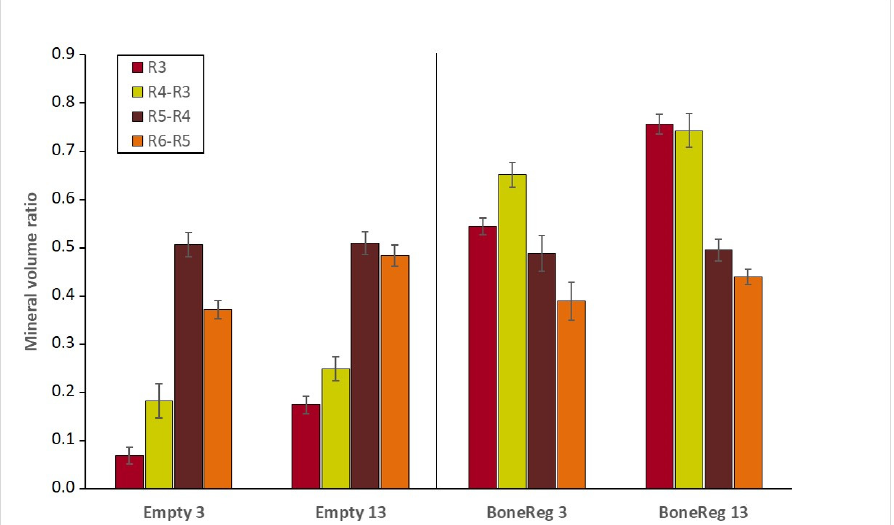
Figure 6. Mineral volume ratio in a virtual cylinder (R3) and tubes R4-R3, R5-R4 and R6-R5 in BoneReg-Inject™ samples after 3 months (BoneReg 3) and 13 months (BoneReg 13) and in the empty control (Empty 3 and Empty 13). Mean and SEM ( n = 15 for each treatment). Mineral content within the implanted scaffold at 13 months postoperatively was significantly higher than at 3 months postoperatively (R3 t -test, p < 0.001 and R4-R3 t -test, p < 0.05). In the empty drill holes, mineral content within R3 was significantly higher after 13 months ( t -test, p < 0.001). A significant increase in mineral